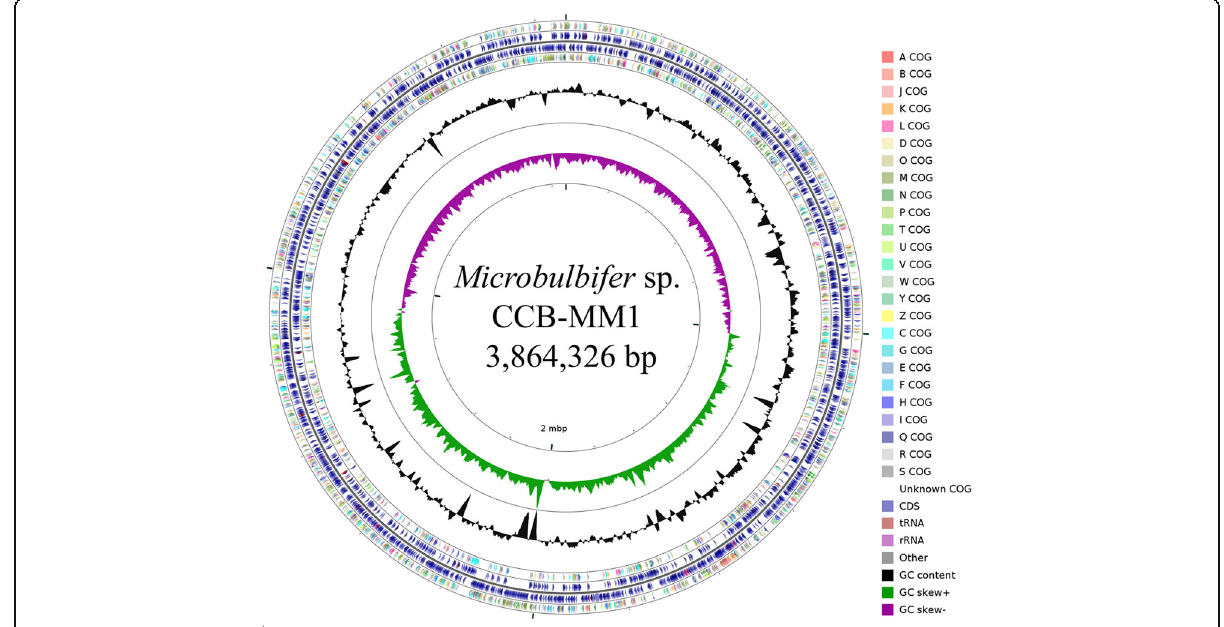
Fig. 3 Circular map of the genome of Microbulbifer sp. CCB-MM1 generated using CGView Comparison Tool [44]. Circles (from outside) representing the following: 1. COG functional categories for forward coding sequence; 2. Forward sequence features; 3. Reverse sequence features; 4. COG functional categories for reverse coding sequence; 5. GC content; 6. GC skew